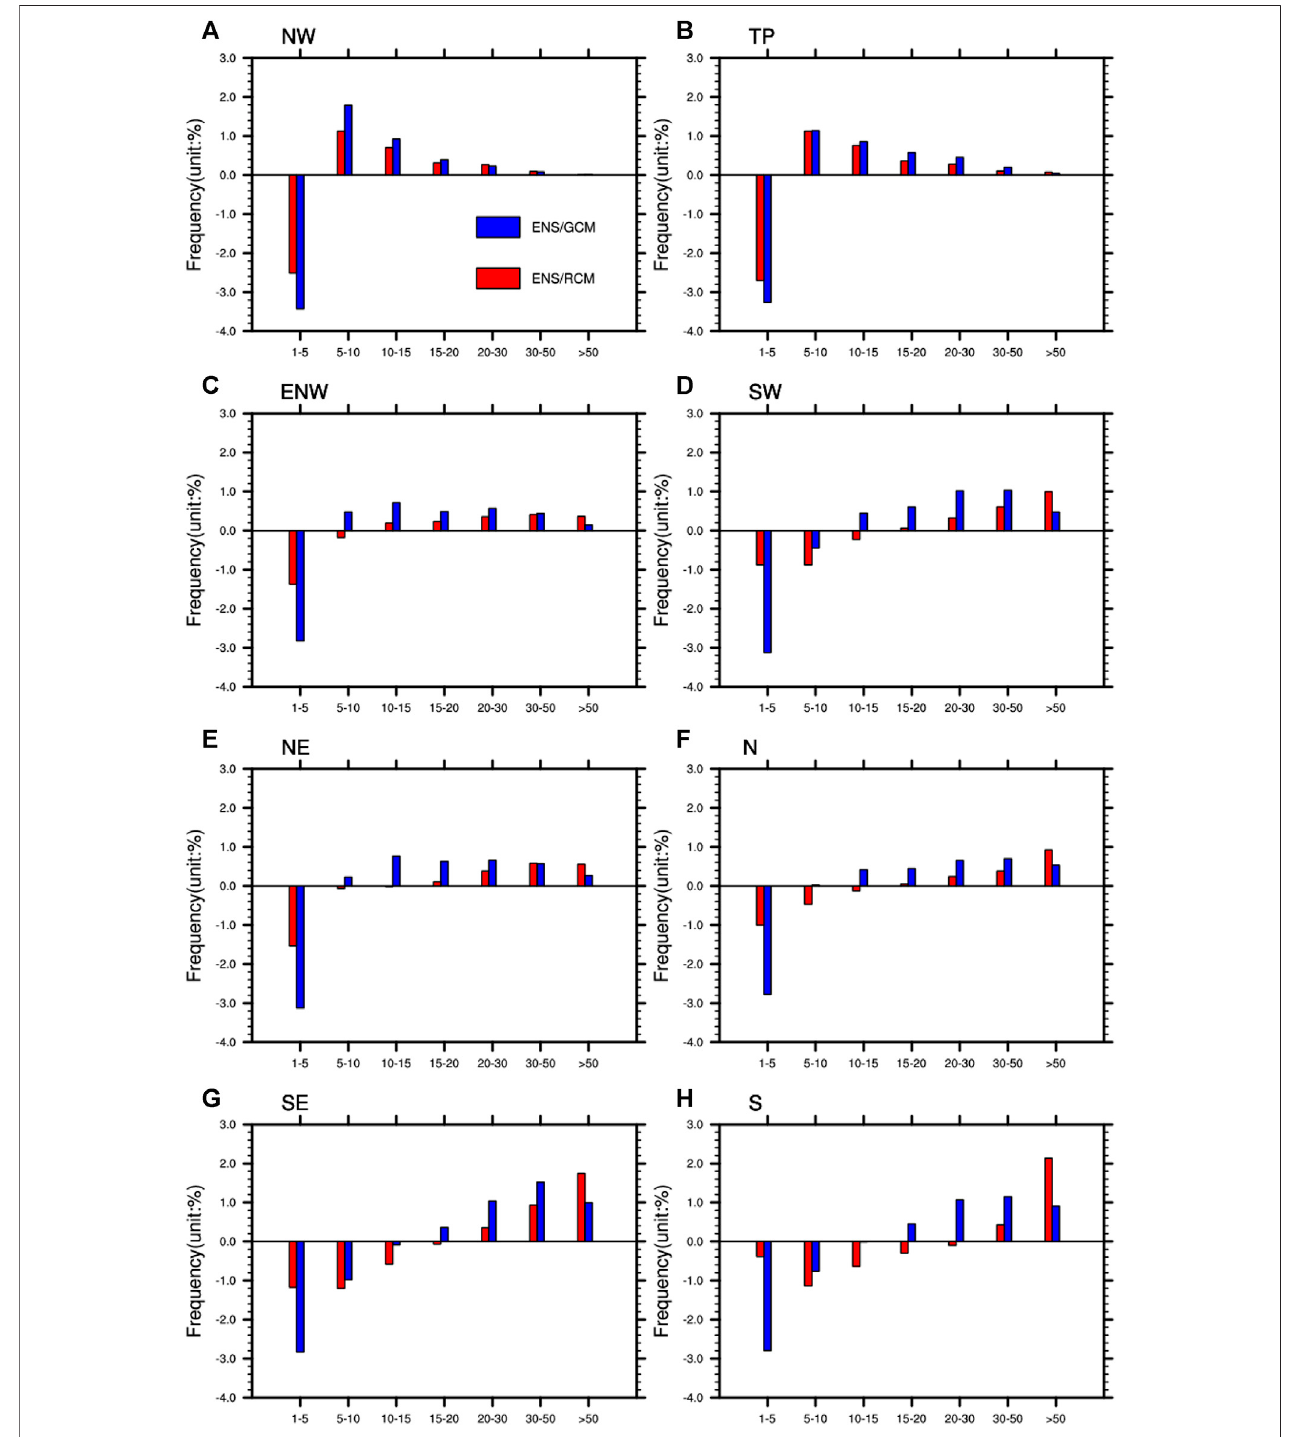
FIGURE 8 | Changes in frequencies of daily precipitation in the eight sub-regions under the RCP8.5 scenario in the historical period and the future period of 2066 – 2095. The blue bar and the red bar represent the ensemble mean of GCMs and the RCMs simulations, respectively.